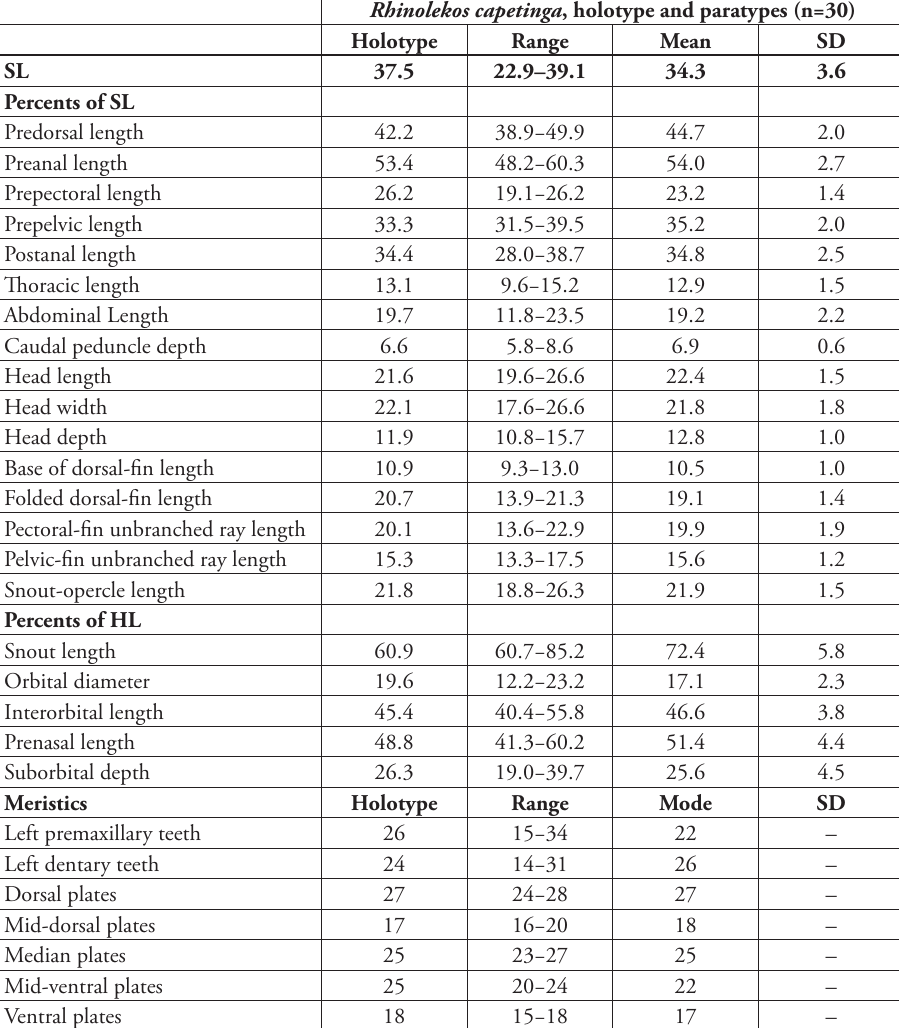
Table 1. Morphometrics and meristic data for R. capetinga . SD, standard deviation. Rhinolekos capetinga , holotype and paratypes (n=30) Holotype